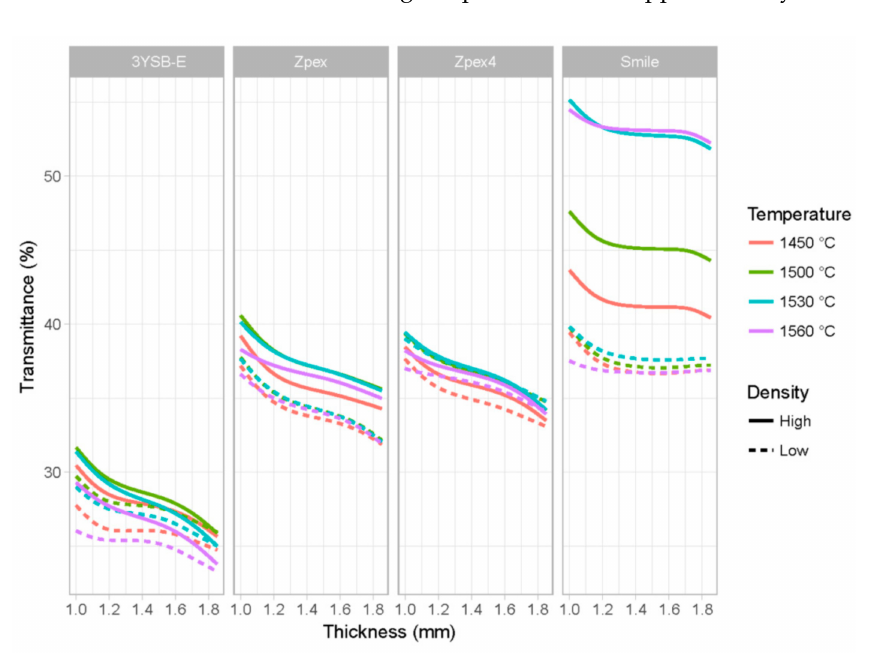
Figure 7. Influence of density and sintering temperature on zirconia transmittance